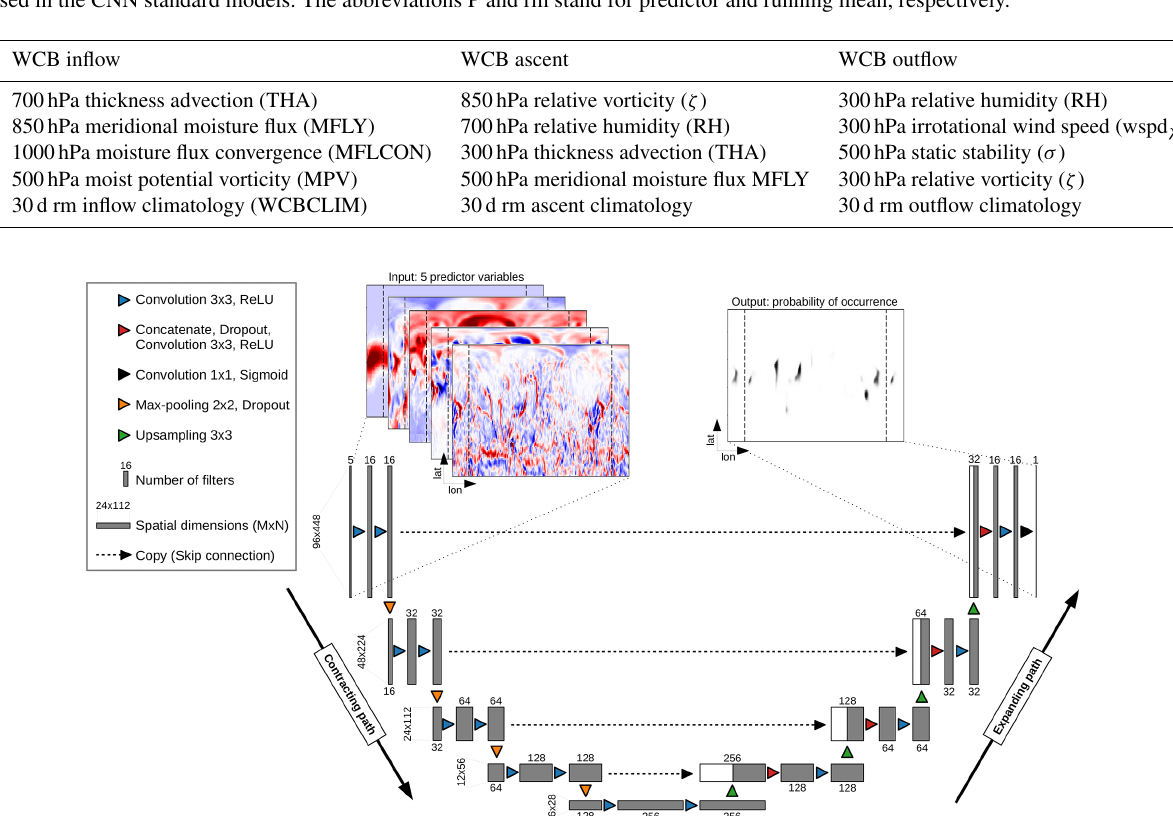
Figure 1. The architecture of the UNet, which follows an encoder–decoder structure with a contracting path and an expanding path. Both paths consist of four blocks each with three layers. A final 1 × 1 convolutional layer reduces the number of feature maps from 16 to 1. See main text for detailed